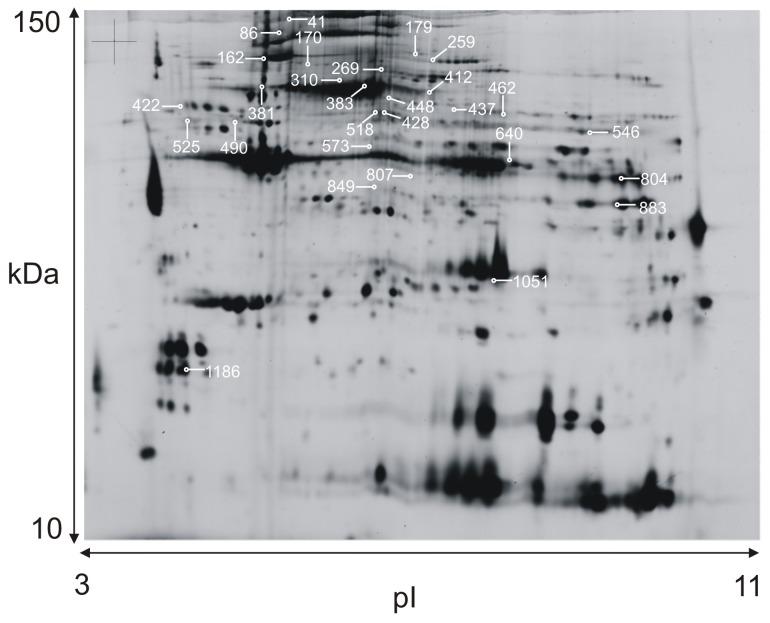
A typical 2-DE gel pattern of human trapezius muscle homogenate.(pH 3–11 and 12.5% SDS). Identified proteins marked with spot ID numbers, available in table 1.